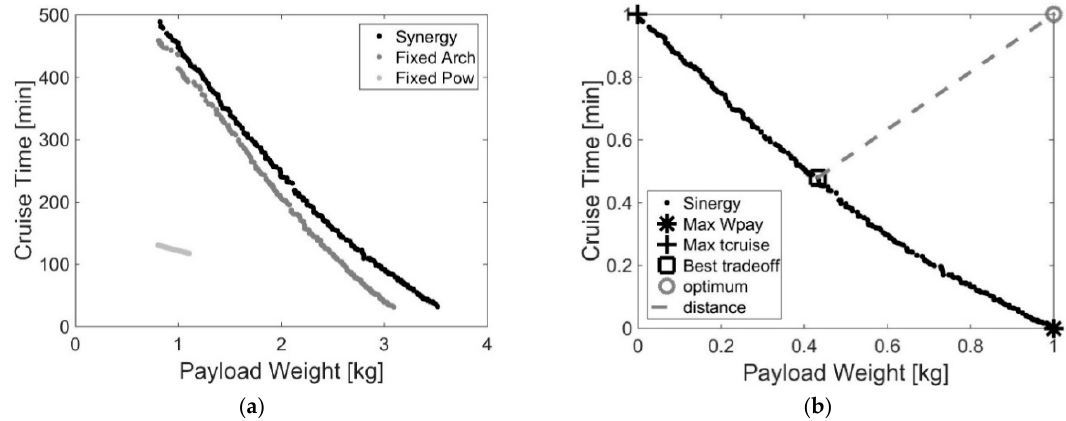
Figure 4. Pareto fronts the VTOL-UAV optimization problem. ( a ) Comparison of the three problems; and ( b ) choice of the optimal solutions. Table 3. Design variables of the three optimal design points of the VTOL-UAV optimization problem. Design